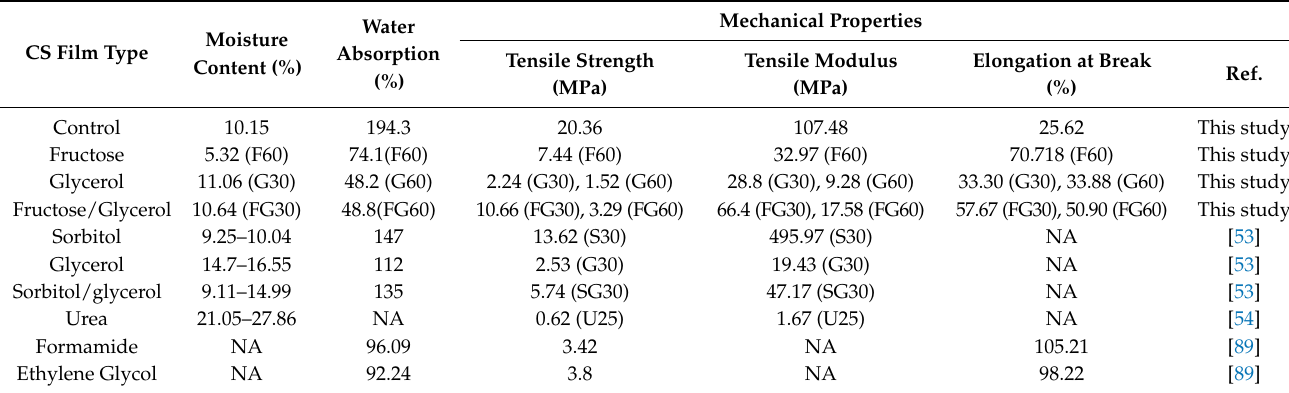
Table 4. Comparison of F-plasticized film properties with previous